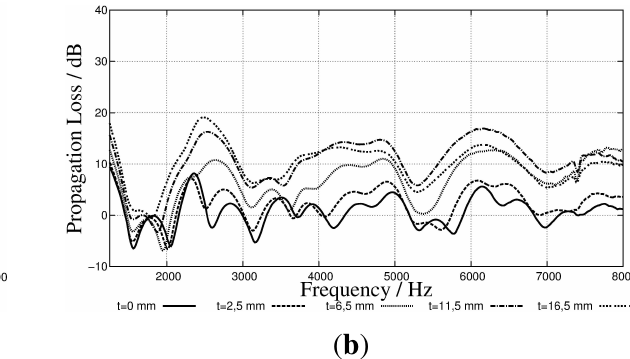
Figure 2. Propagation loss due to absorption silencers. ( a ) Absorption coefficient of SFF 50; ( b ) Propagation loss with SFF 50 and L = 20 mm ; ( c ) Propagation loss with SFF 50 and L = 60 mm ; ( d ) Propagation loss with SFF 50 and t = 16 , 5 mm ; ( e ) Propagation loss with different sintered fibre felts with t = 2 , 5 mm and L = 60 mm ; ( f ) Propagation loss with different sintered fibre felts with t = 16 , 5 mm and L = 60 mm